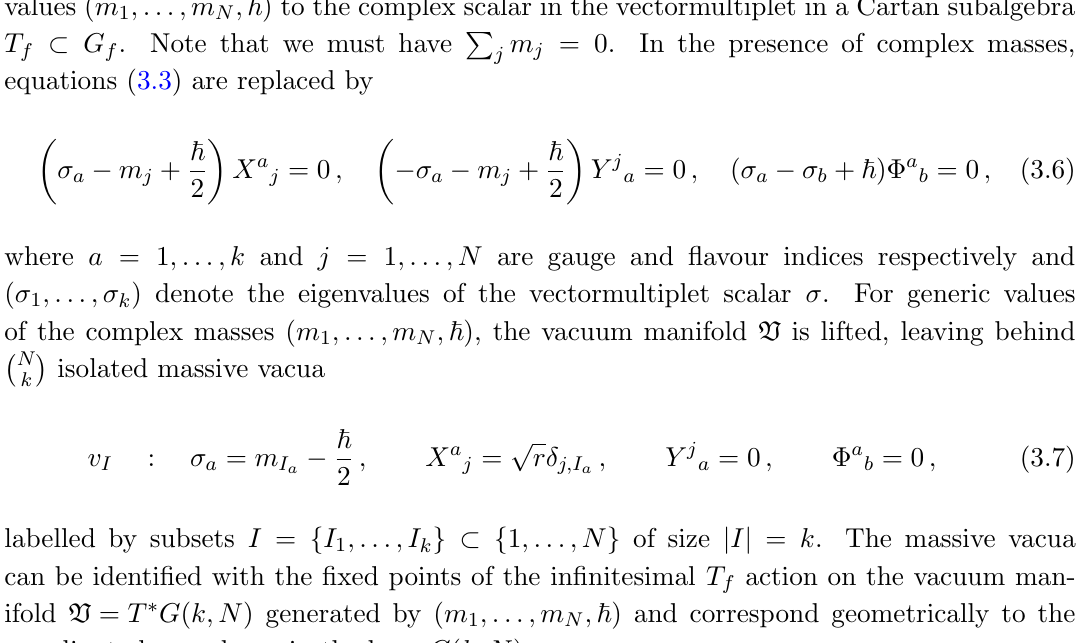
CP 1 with (cid:12)xed points